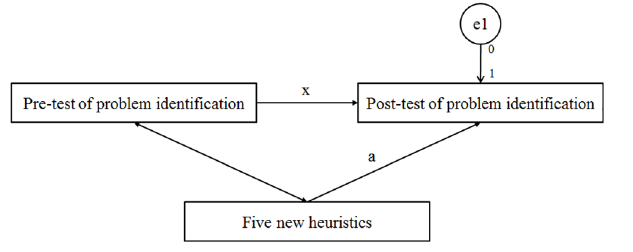
Fig 4. Hypothesis